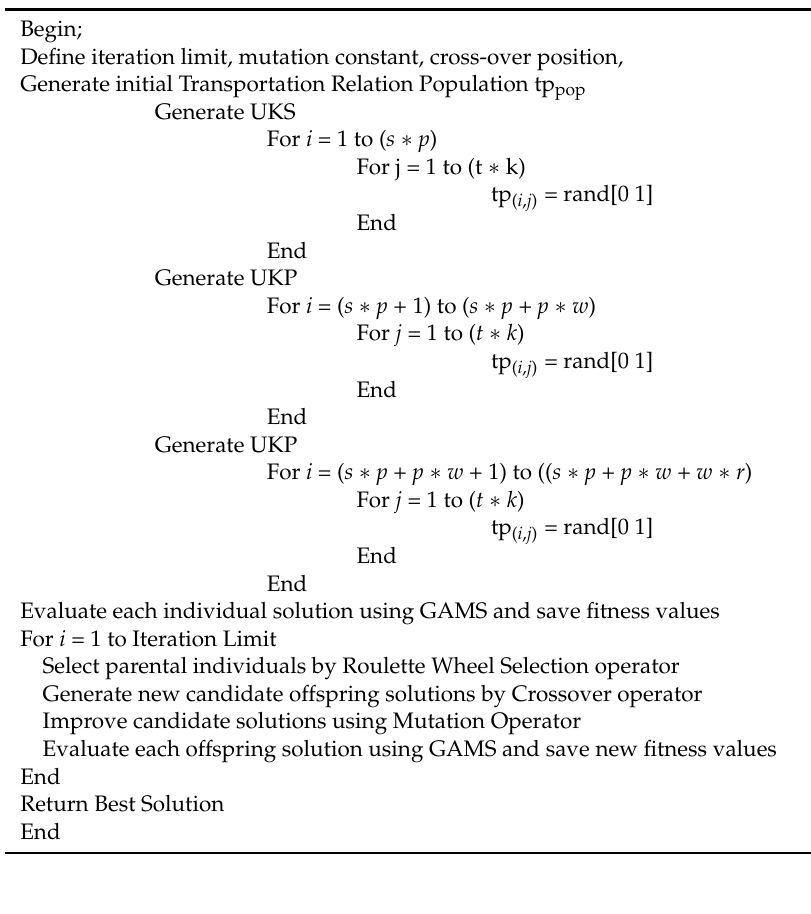
Table 2. Pseudo-code for